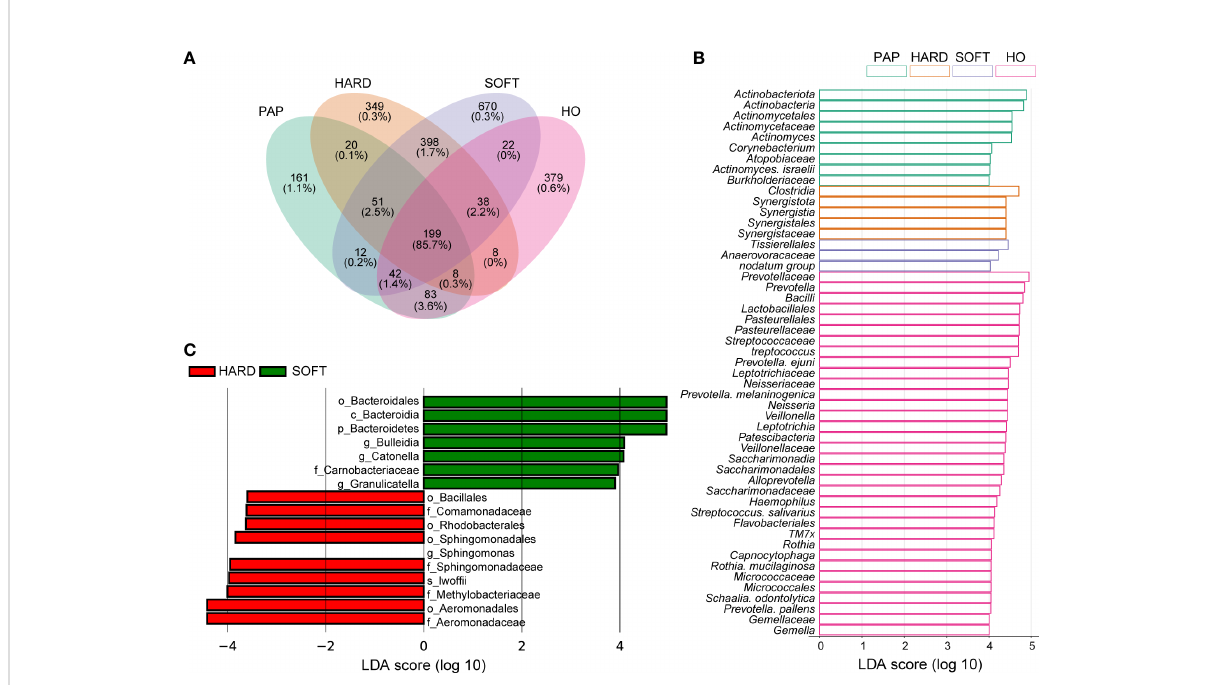
FIGURE 3 Distribution of the microbiota composition and biomarkers. (A) Venn diagram of the taxonomic distribution, the percentage under OTU numbers represent reads percentages of all sequencing data. (B-C) The result of linear discriminant analysis integrated with effect size (LEfSe). Microbial marker taxa with signi fi cant abundance differences among HO, PAP, HARD and SOFT (B) and between HARD and SOFT (C) (LDA > 3.5, p <